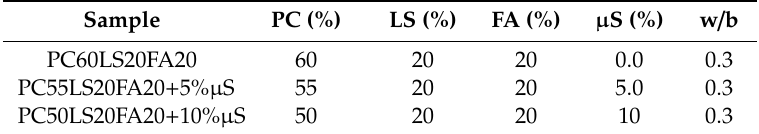
Table 2. Quaternary µ S enhanced cement paste formulations—Mix Proportions % by total mass of binder.